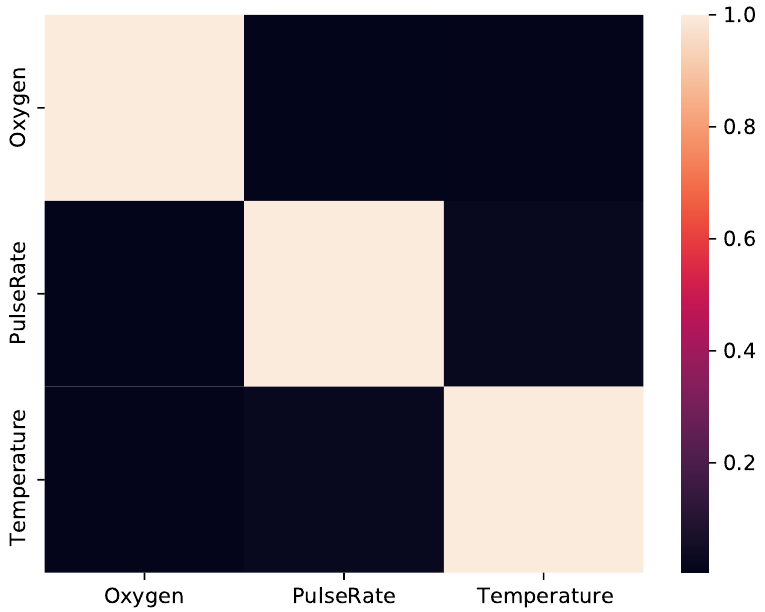
Figure 8. Correlation matrix for the parameters of the dataset. Table 4. Mean inference time for 10 fold cross-validation on the test dataset.